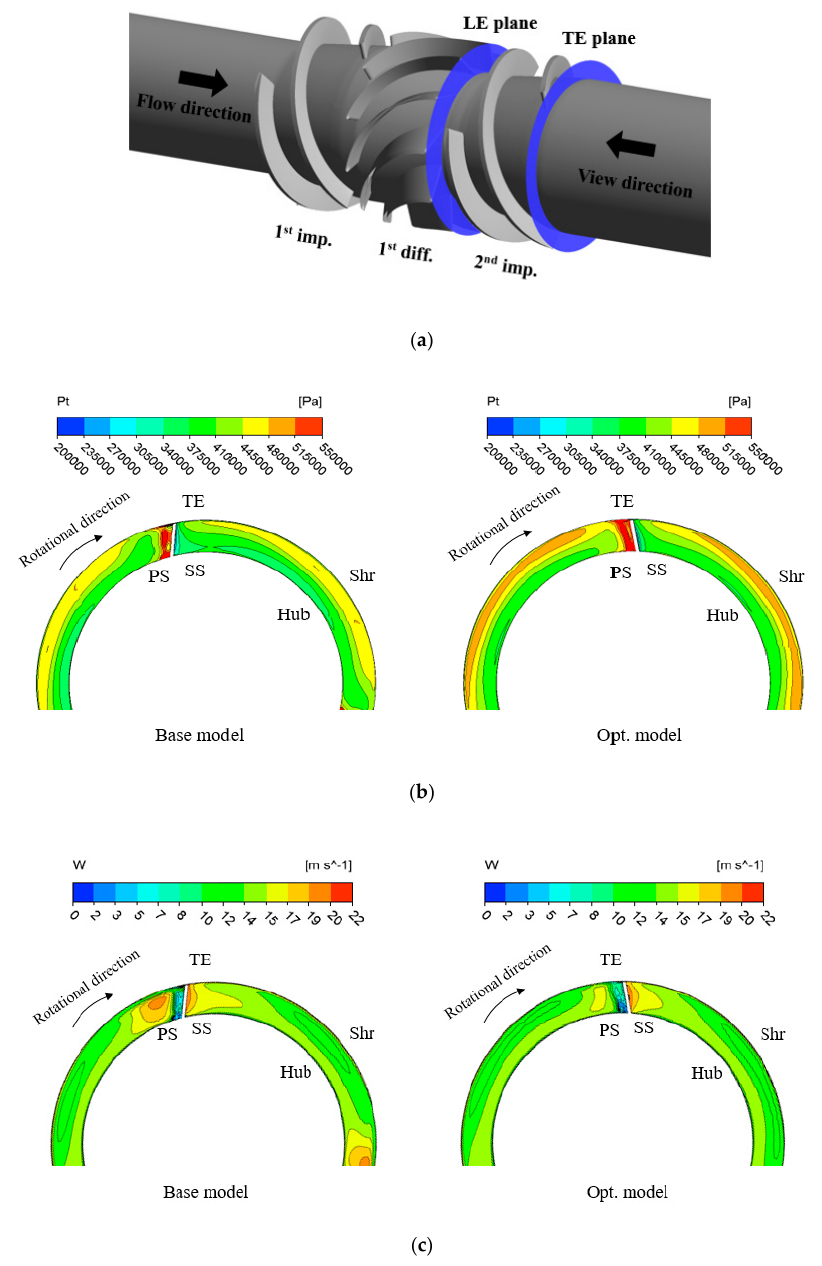
Figure 13. Internal flow contours near the trailing edge of the 2nd impeller. ( a ) Location of observation; ( b ) total pressure contour; ( c ) velocity contour. ( b ) total pressure contour; ( c ) velocity